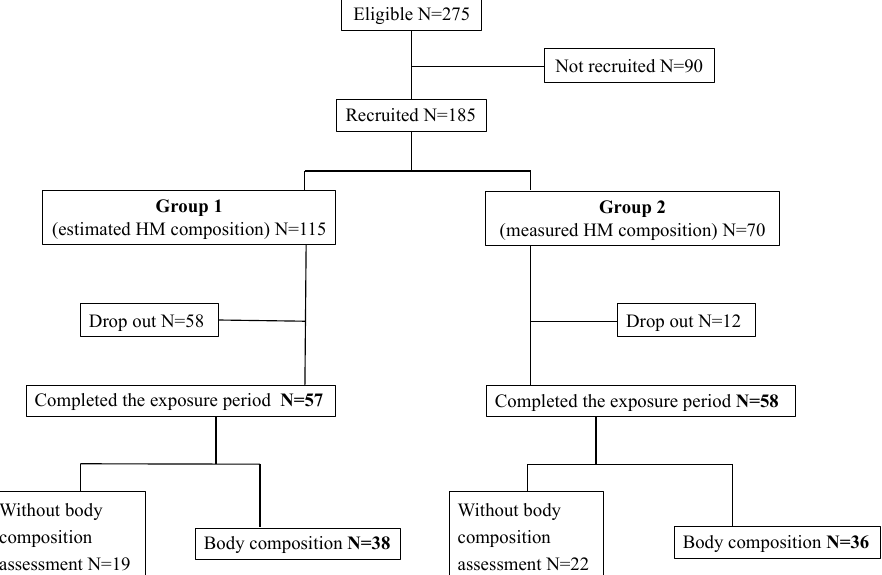
Figure 1. Study fl owchart.